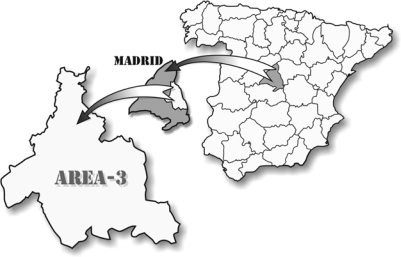
The geographical area of the study.